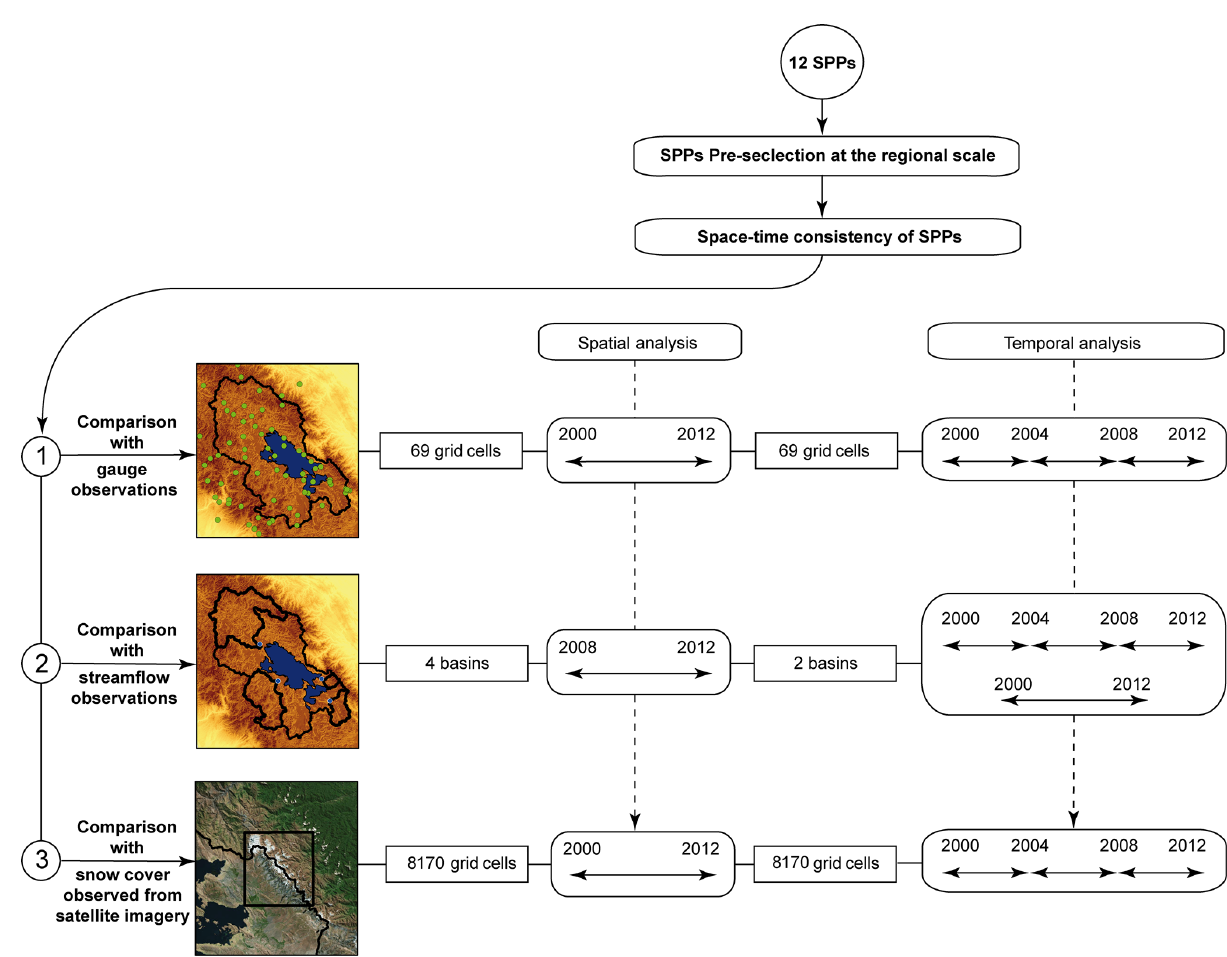
Figure 3. Flowchart of the main steps from SPP preselection to successive assessment approaches including (1) comparison between SPPs and gauge observations, (2) sensitivity analysis of runoff modelling to the various SPPs at the four basin outlets and (3) sensitivity analysis of snow modelling to the various SPPs over a subset mountainous area in the